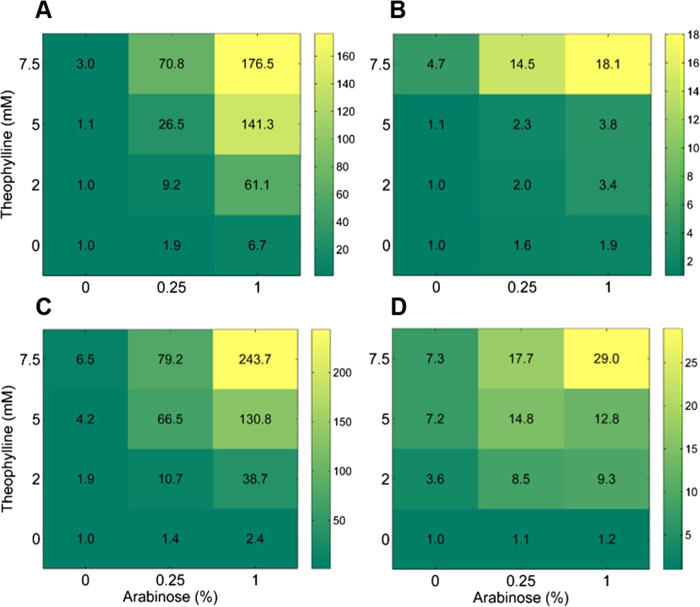
Repression trajectories of PConst based target modules.Repression trajectory of RiboTALE repression system that consists of (A) RiboTALE module pRibo1TALE2 and target module pC5TBS2, (B) RiboTALE module pRibo2TALE2 and target module pC5TBS2, (C) RiboTALE module pRibo1TALE2 and target module pC6TBS2, (D) RiboTALE module pRibo2TALE2 and target module pC6TBS2. Color bar indicates fold repression.